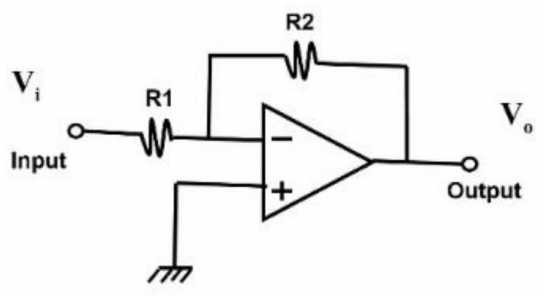
Figure 6. Inverter amplifier